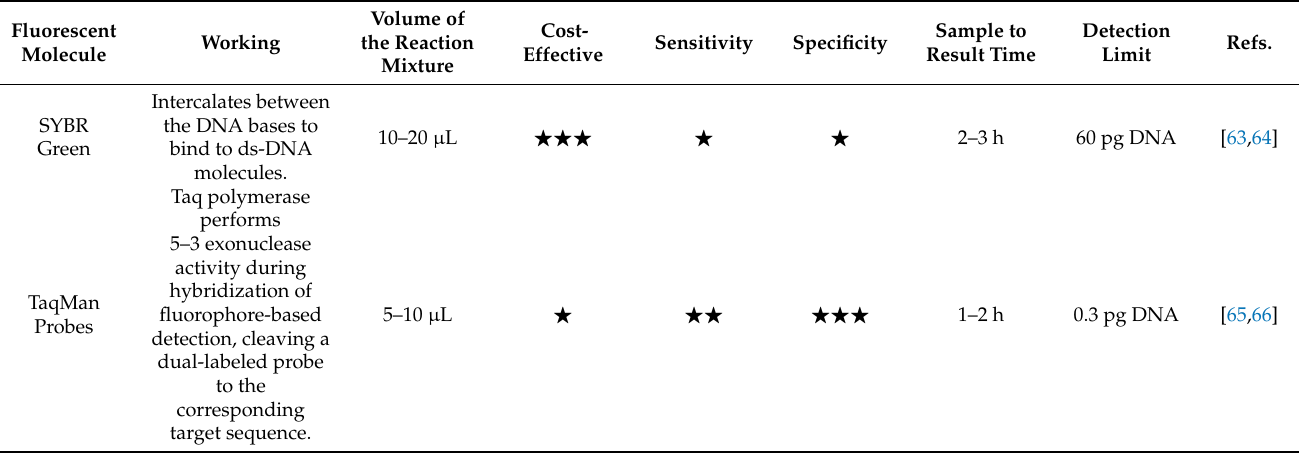
Table 1. Comparison of four different types of fluorescent DNA probes currently used in real-time PCR for diagnosing polymicrobial